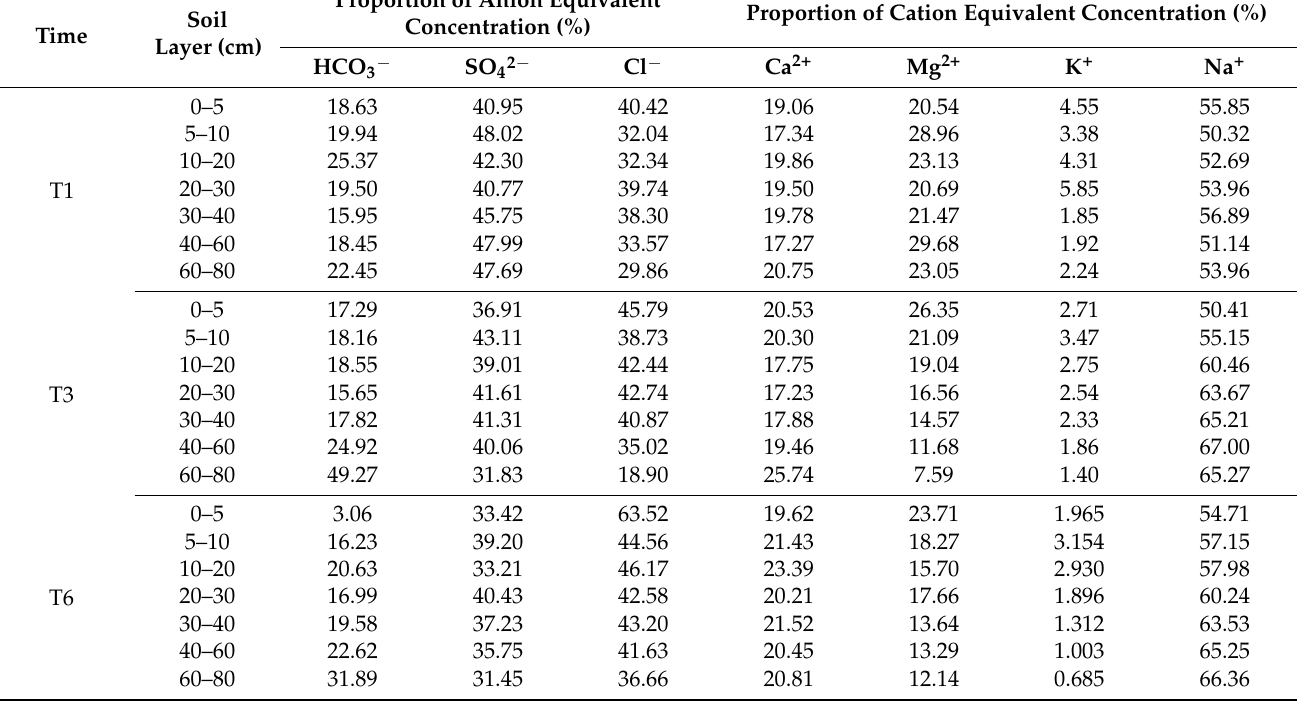
Table 2. Soil anion and cation composition.